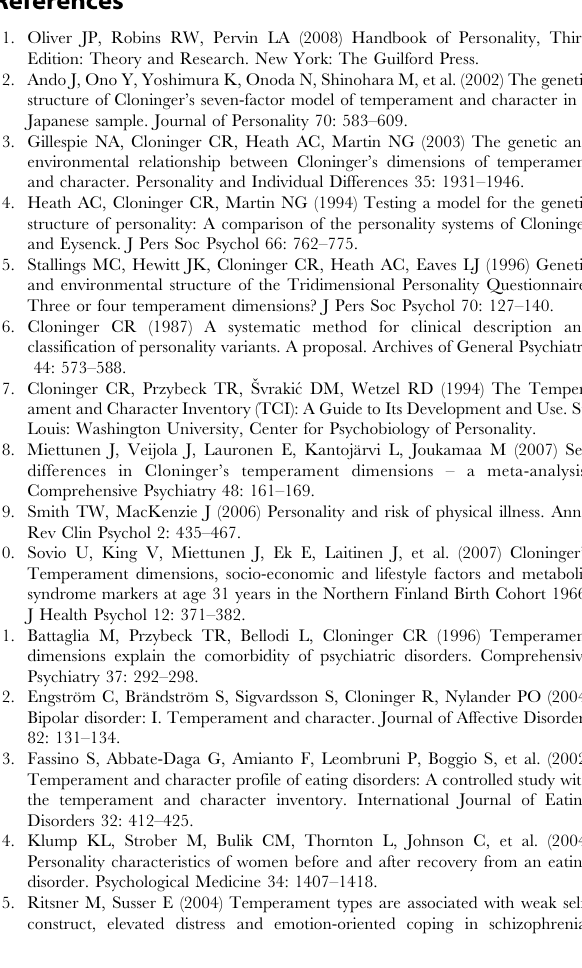
Table S2 Clusterings based on NFBC66 four-cluster model vs. YF four-cluster mode. Table S3 Clusterings based on NFBC66 two-cluster model vs. YF two-cluster mode. Table S4 Self-rated physical capacity, life habits, health and stress reactivity data from the 31-year follow-up in NFBC66 females. Table S5 Self-rated physical capacity, life habits, health and stress reactivity data from the 31-year follow-up in NFBC66